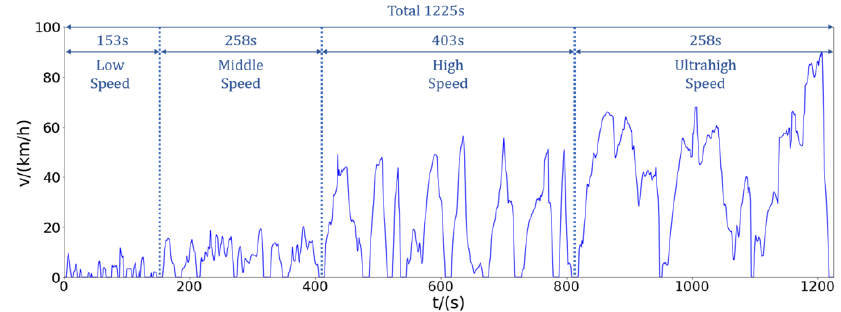
Figure 15. Transient driving cycle map.